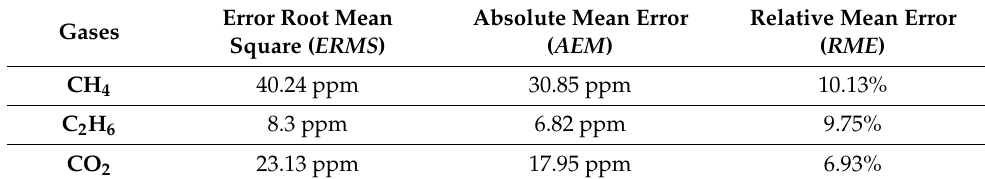
Table 24. Errors between online estimation and offline measurements of gas concentration.